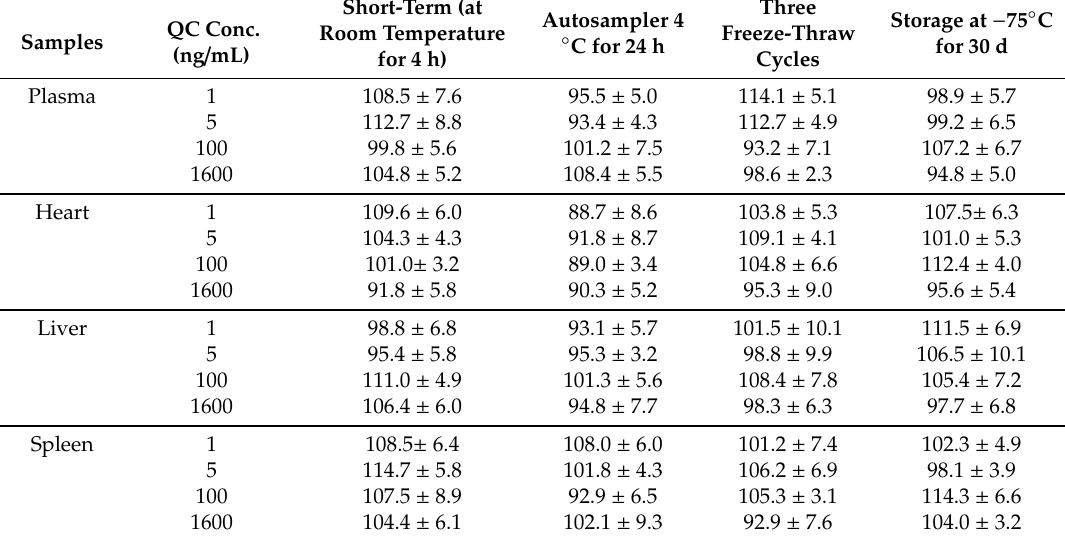
Table 4. Short-term, post-preparative storage, freeze-thaw and long-term stability of alnustone in di ff erent samples ( n =